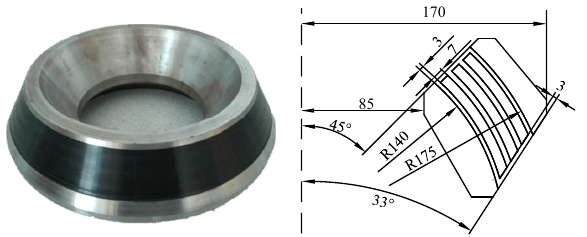
Figure 7. Detailed dimension of the flexible